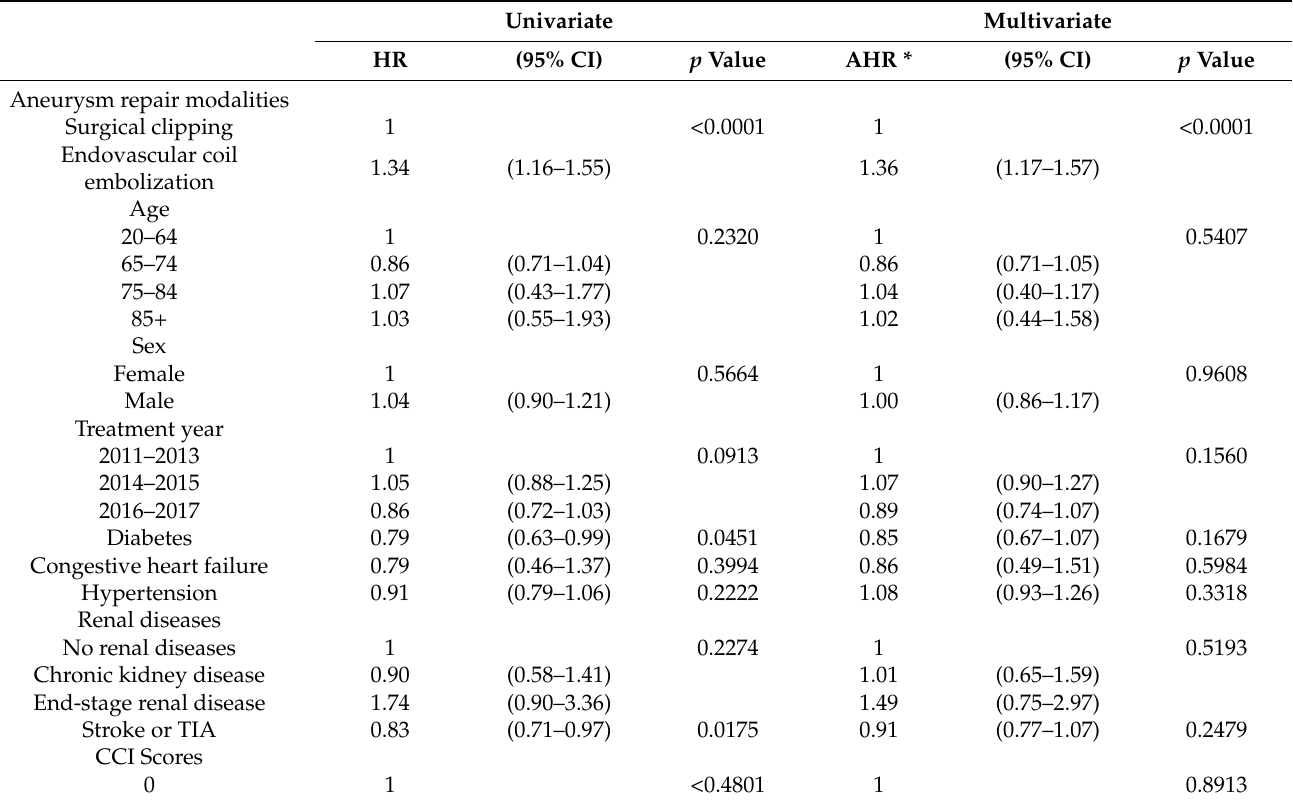
Table 1. Cox proportional hazards regression analysis of the risk of re-rupture among the propensity score-matched patients with ruptured subarachnoid aneurysms undergoing surgical clipping or endovascular coiling.